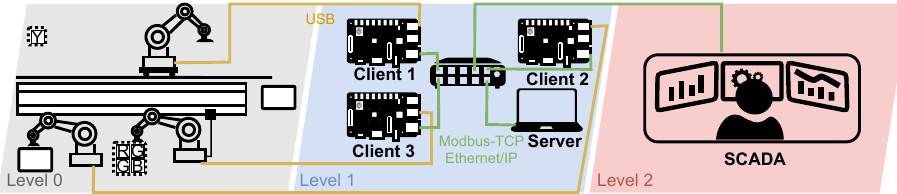
Figure 15. Diagram of industrial production